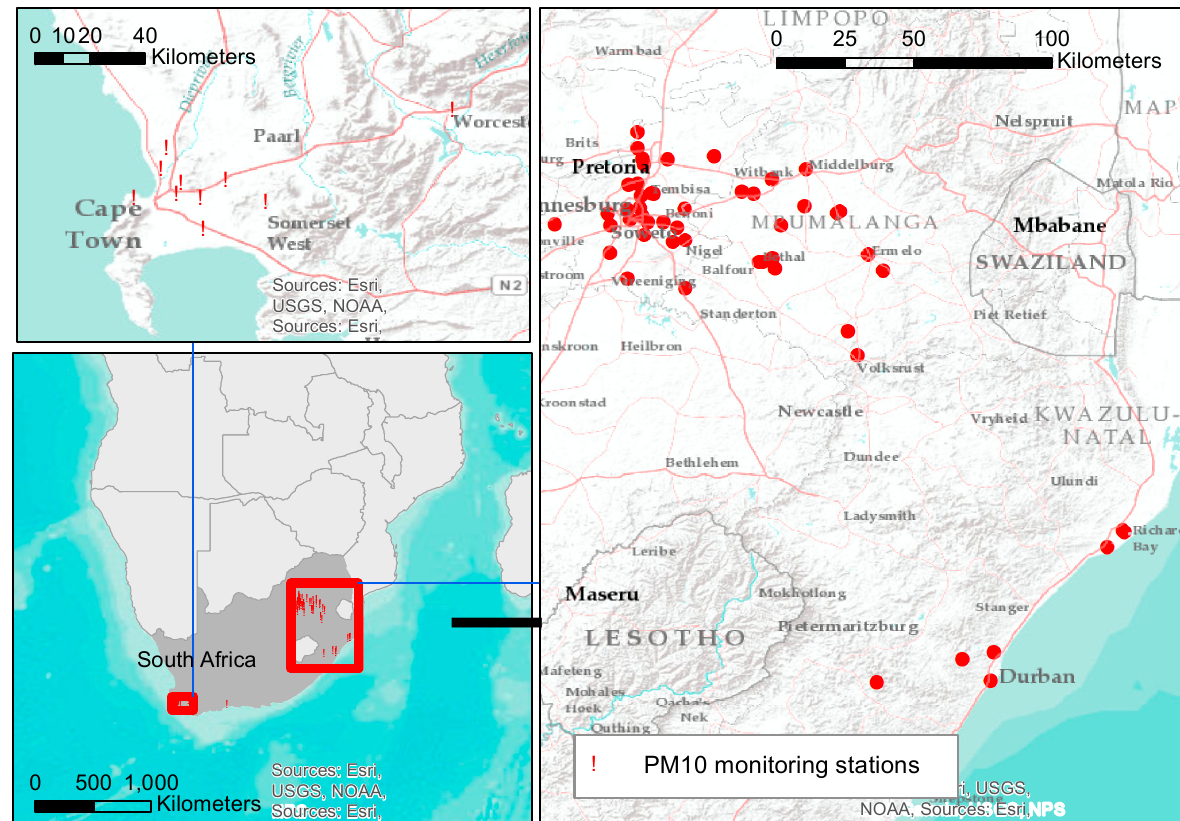
Figure 1. The spatial distribution of particulate matter (PM 10 ) monitoring stations across the four provinces of South Africa operating at some point during 2010–2017.